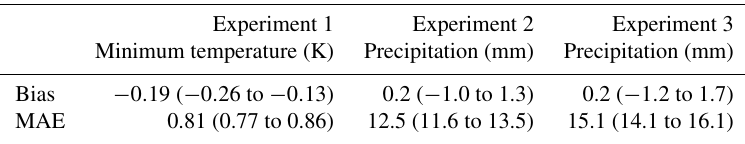
Table 6. Calibration sample evaluation statistics for the three